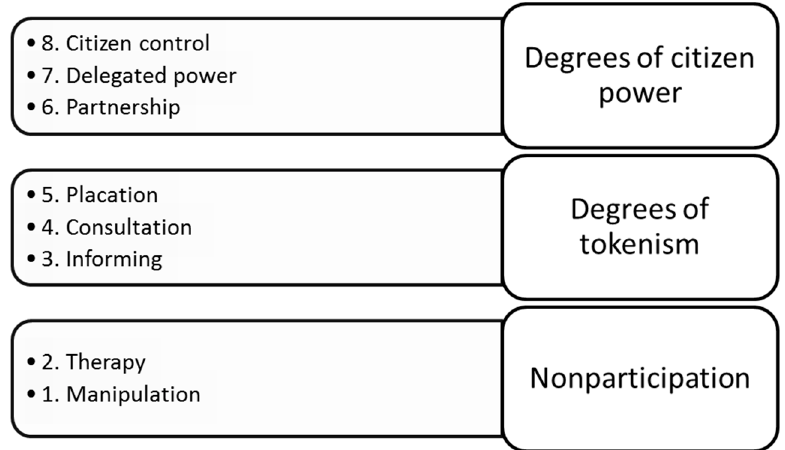
Figure 2. Eight levels of participation within Arnstein (1969)’s Ladder of Citizen Participation [15].